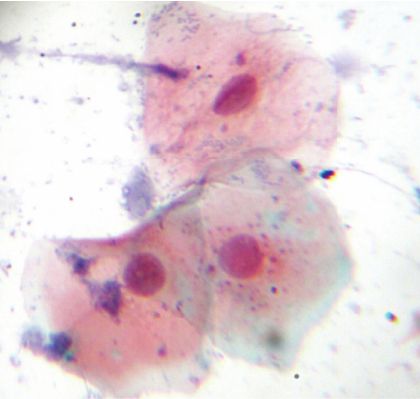
Figure 3: Photomicrograph showing epithelial cells with enlarged hyperchromatic nuclei and intracytoplasmic vacuoles (40x).